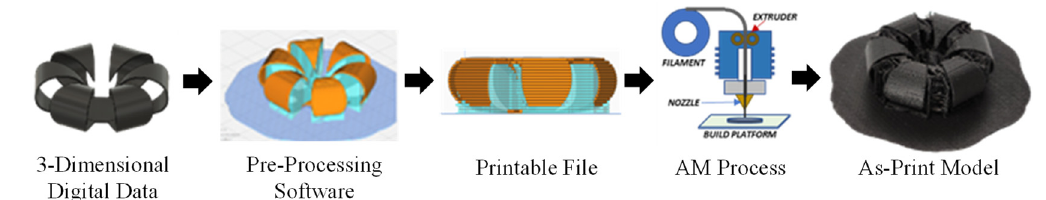
Figure 1. Traditional AM, 3D printing, workflow—from digital to physical.